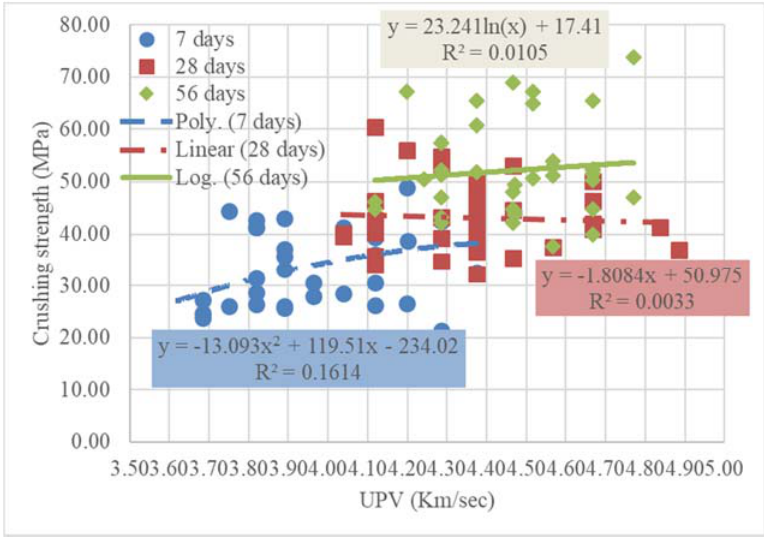
Figure 8. Effect of MW on ultrasonic pulse velocity (UPV) test results. Figure 8. E ff ect of MW on ultrasonic pulse velocity (UPV) test